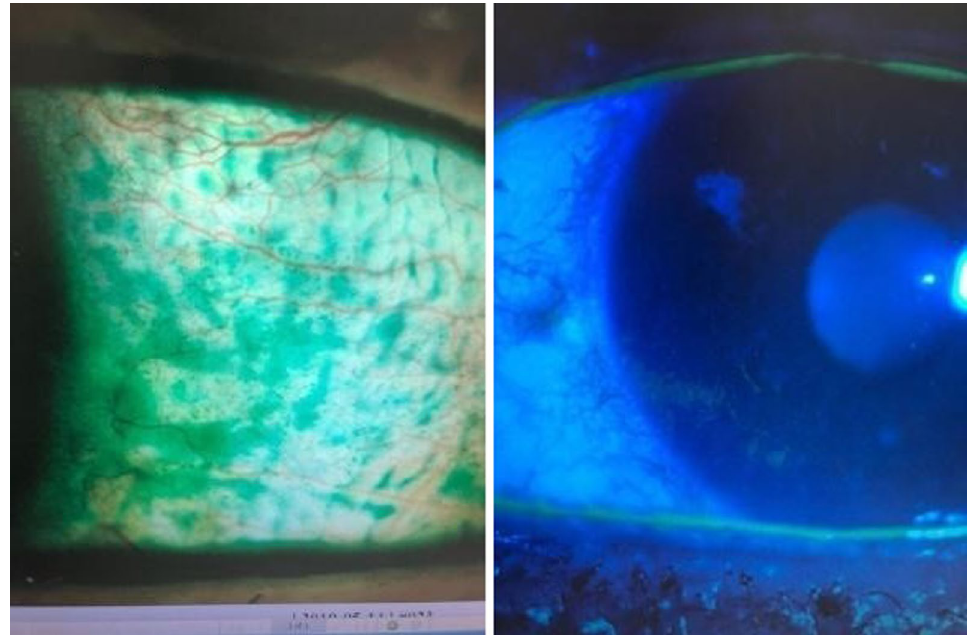
Fig. 1 Ocular surface staining tests using Lissamine ( a ) and Fluorescein ( b ). Findings from a patient enrolled in the study (Courtesy of Dr. Fabiano Cade